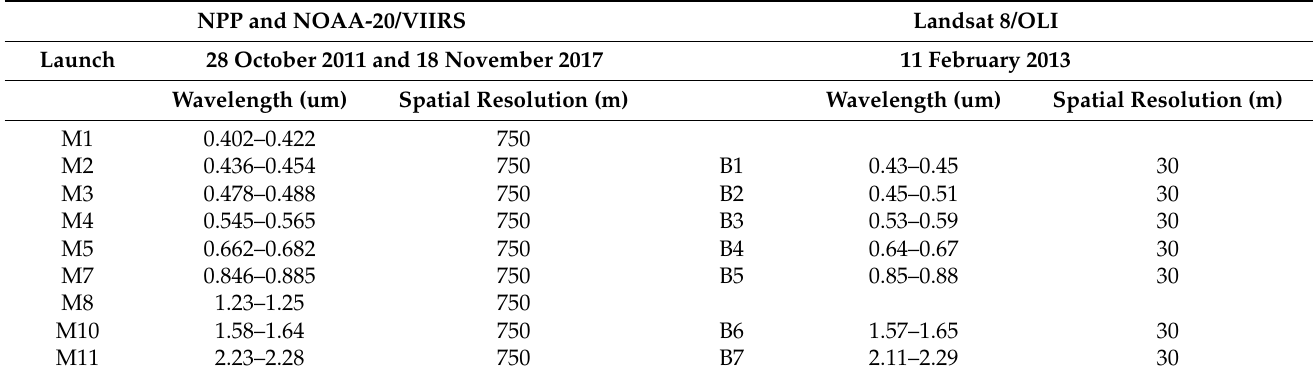
Table 1. Wavelengths and resolutions of the bands of VIIRS and OLI